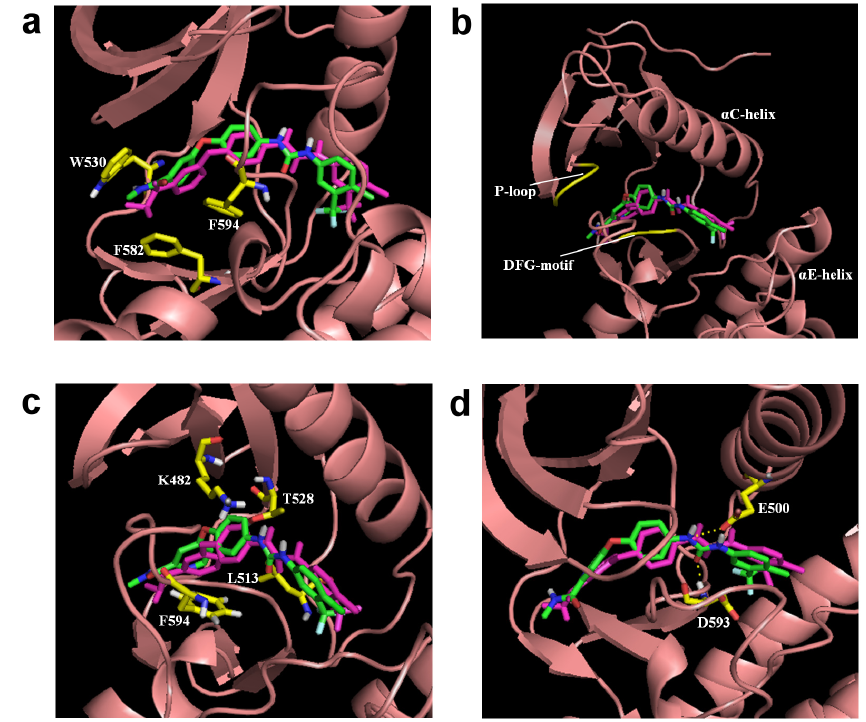
Figure 3. The comparison of regenerated sorafenib to the sorafenib from the crystal structure (in purple) with B-RAF; three hydrophobic interactions within the ( a ) ATP binding pocket, ( b ) allosteric site, ( c ) linker space, and ( d ) two hydrogen bond